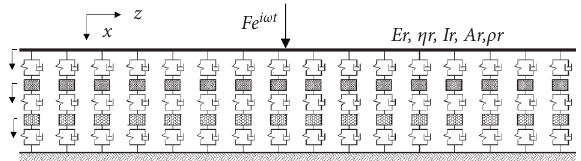
Figure 10: Three-layer-continuous elastic support model of 1/2 ballasted track.